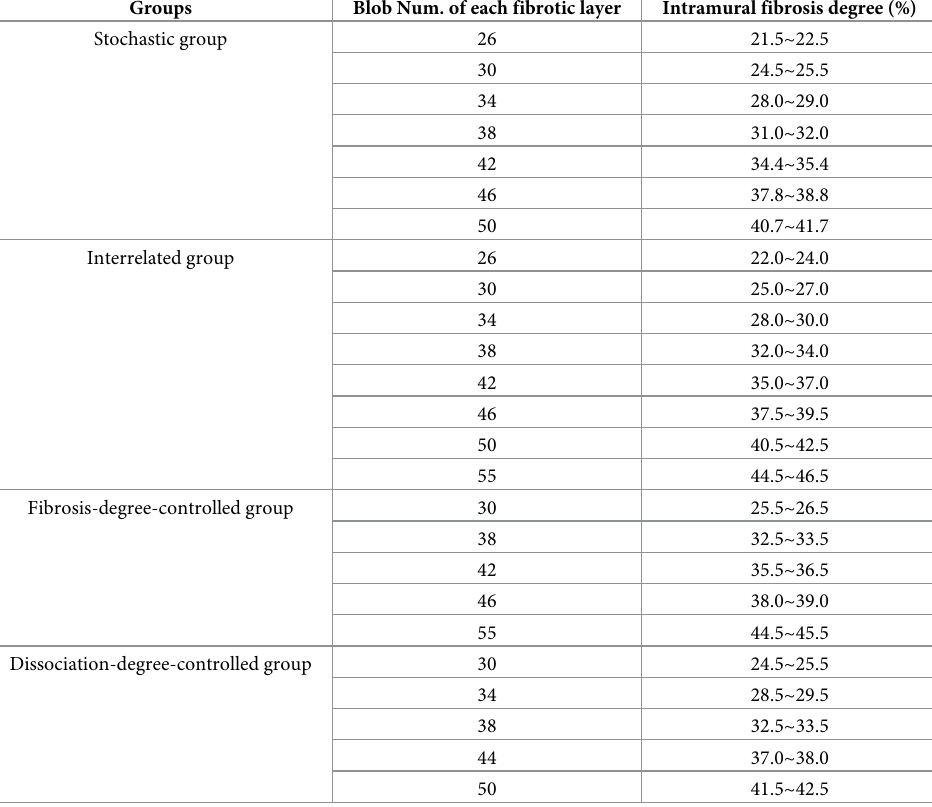
Table 1. The range of the intramural fibrosis degree controlled by the number of fibrotic blobs in the fibrotic